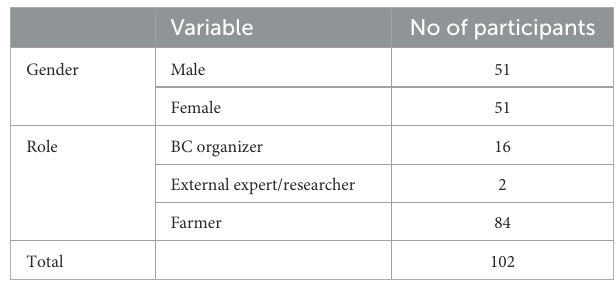
TABLE 1 Gender and role of